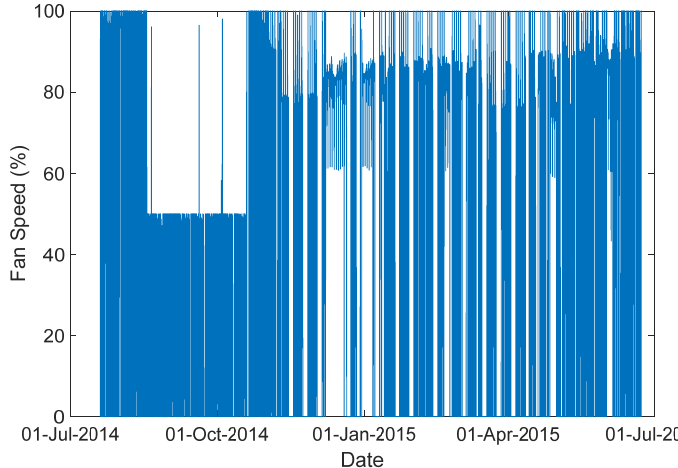
Figure 7. The ventilation system input.